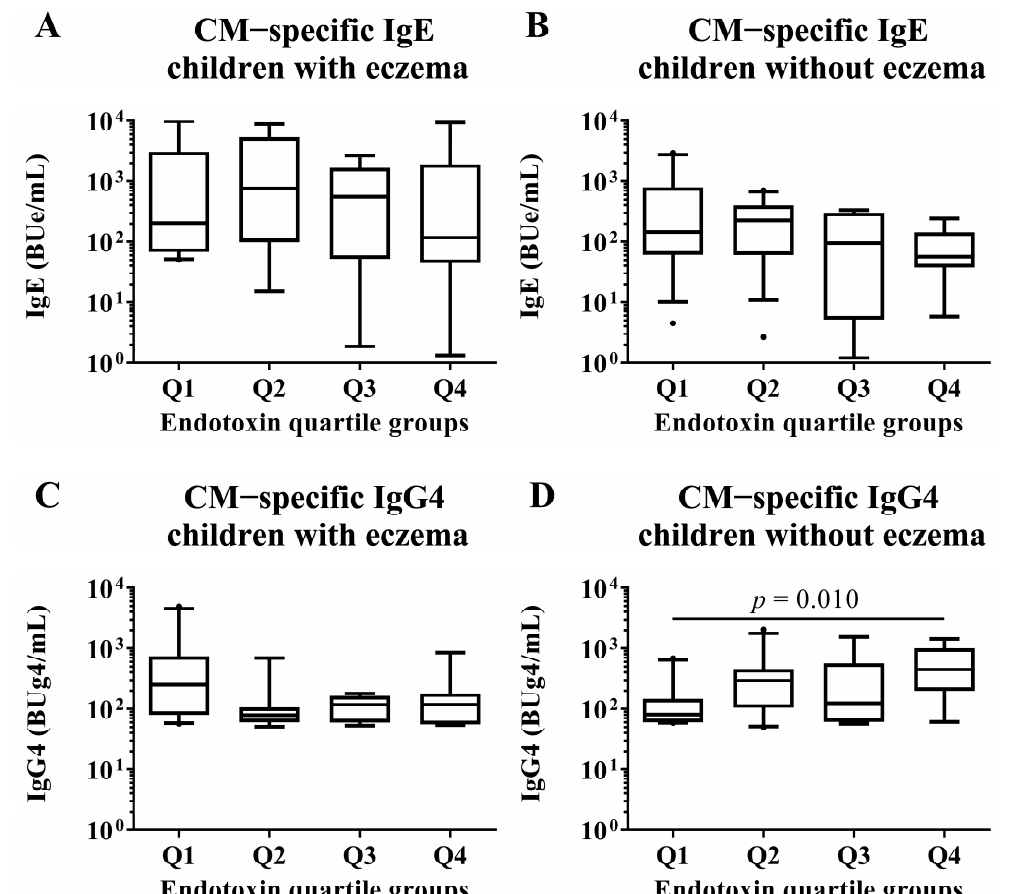
Figure 7. Subgroup analyses by the presence of eczema in children who had CM allergy in their first year of life. Comparisons of CM-specific IgE and IgG4 levels in sera of children at 2 years old among quartile groups of endotoxin concentration (Q1–Q4) per 1 mg of house dust collected from the mattresses of children at 18 months old. These show results in ( A ) CM − specific IgE level in children with eczema, ( B ) CM − specific IgE level in children without eczema, ( C ) CM − specific IgG4 level in children with eczema and ( D ) CM − specific IgE level in children without eczema. p -values were calculated for each log-converted Ig level using Mann–Whitney U test based on Q1. p -values < 0.05 were considered significant. Table 2. Correlation between endotoxin concentration and EW- and CM-specific IgE and IgG4 levels in subgroups of children with and without